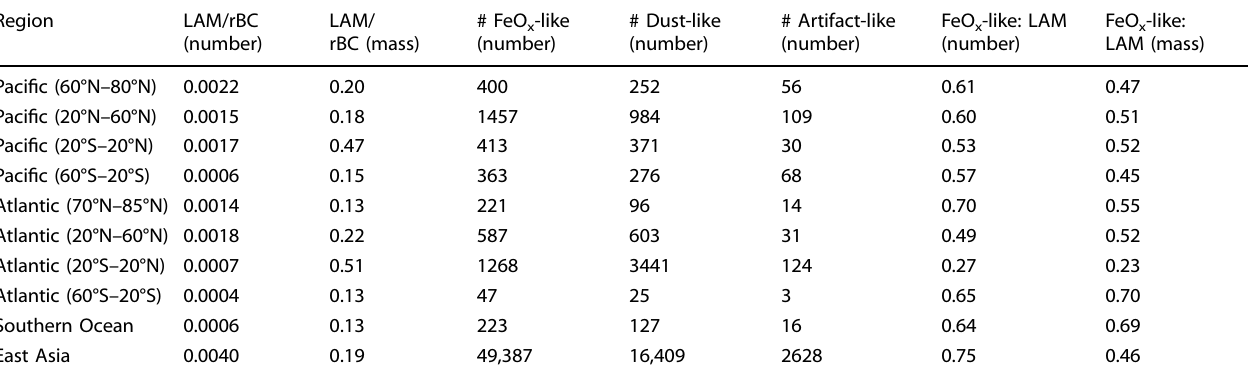
Table 1. Characteristics of LAM observed in cloud-free regions with an SP2.